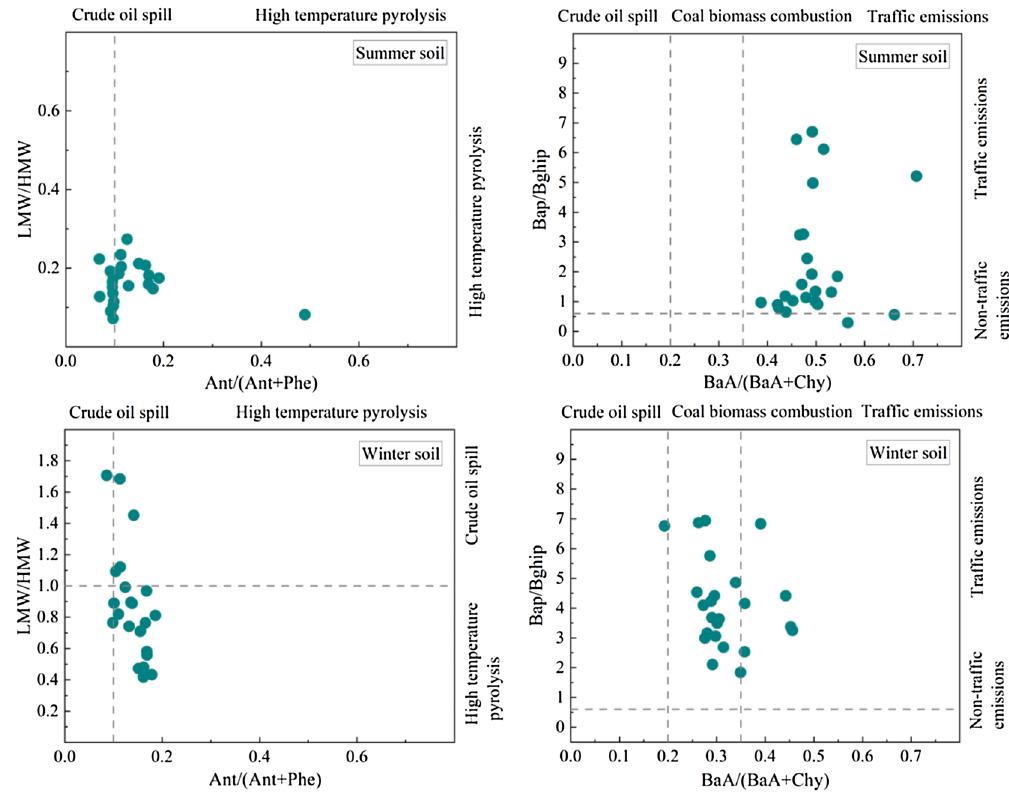
Figure 3. Source analysis of soil